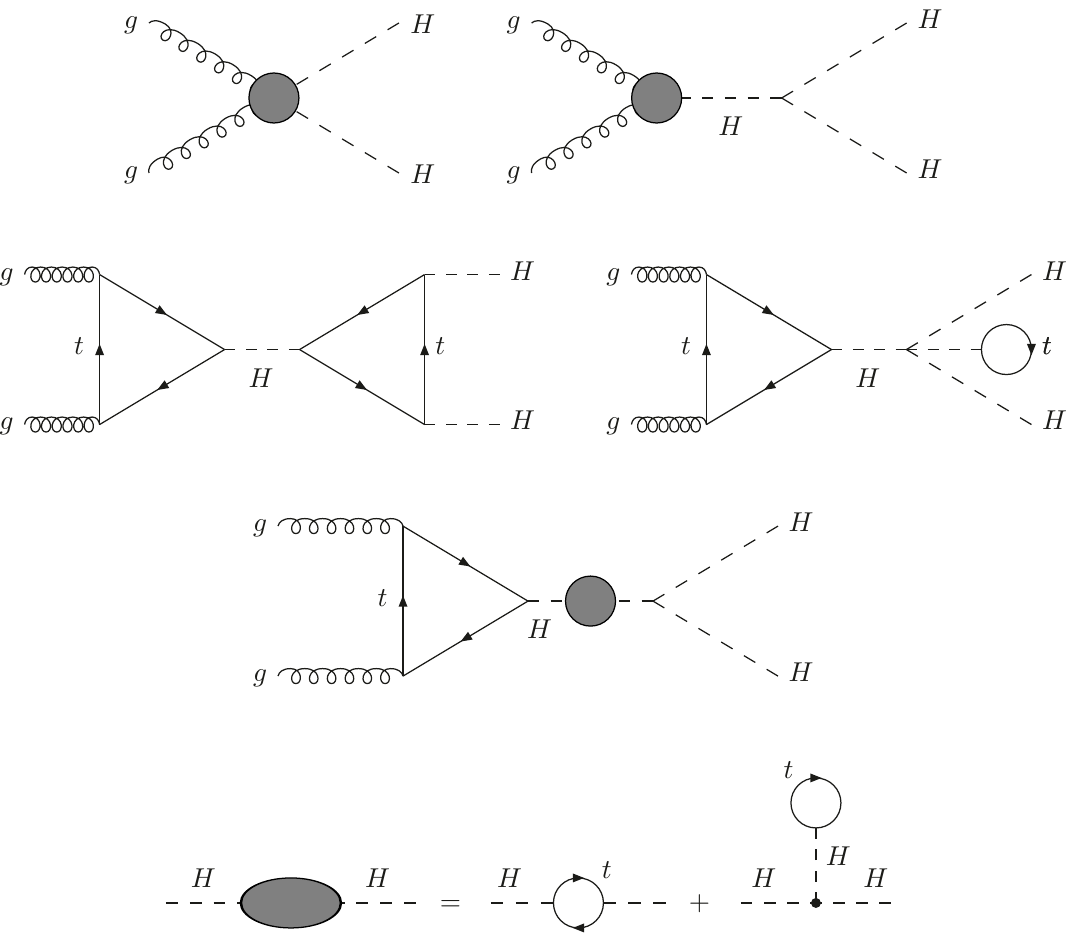
Figure 3 . Generic diagrams describing the top-Yukawa-induced electroweak corrections to Higgs- boson pair production via gluon fusion. The blobs of the first two diagrams are determined by the effective Lagrangian of eq. (3.3) in the